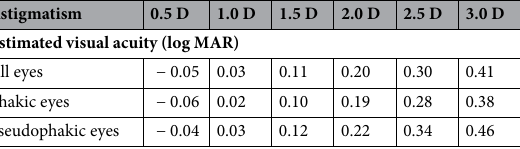
Table 2. Estimated visual acuity according to the amount of astigmatism, based on the regression formulas.